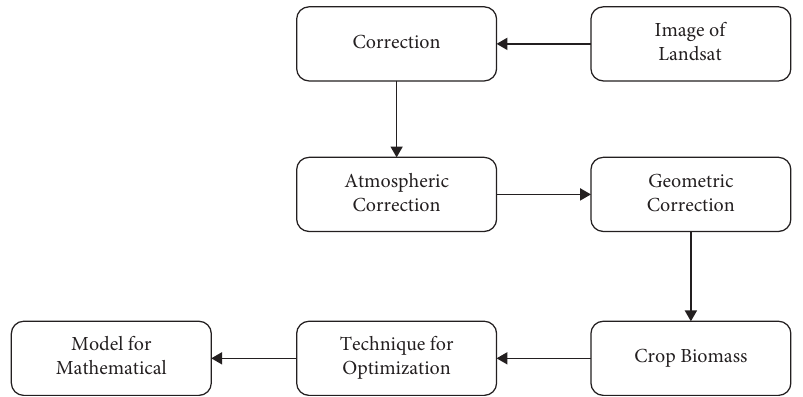
Figure 2: The newly developed mathematical